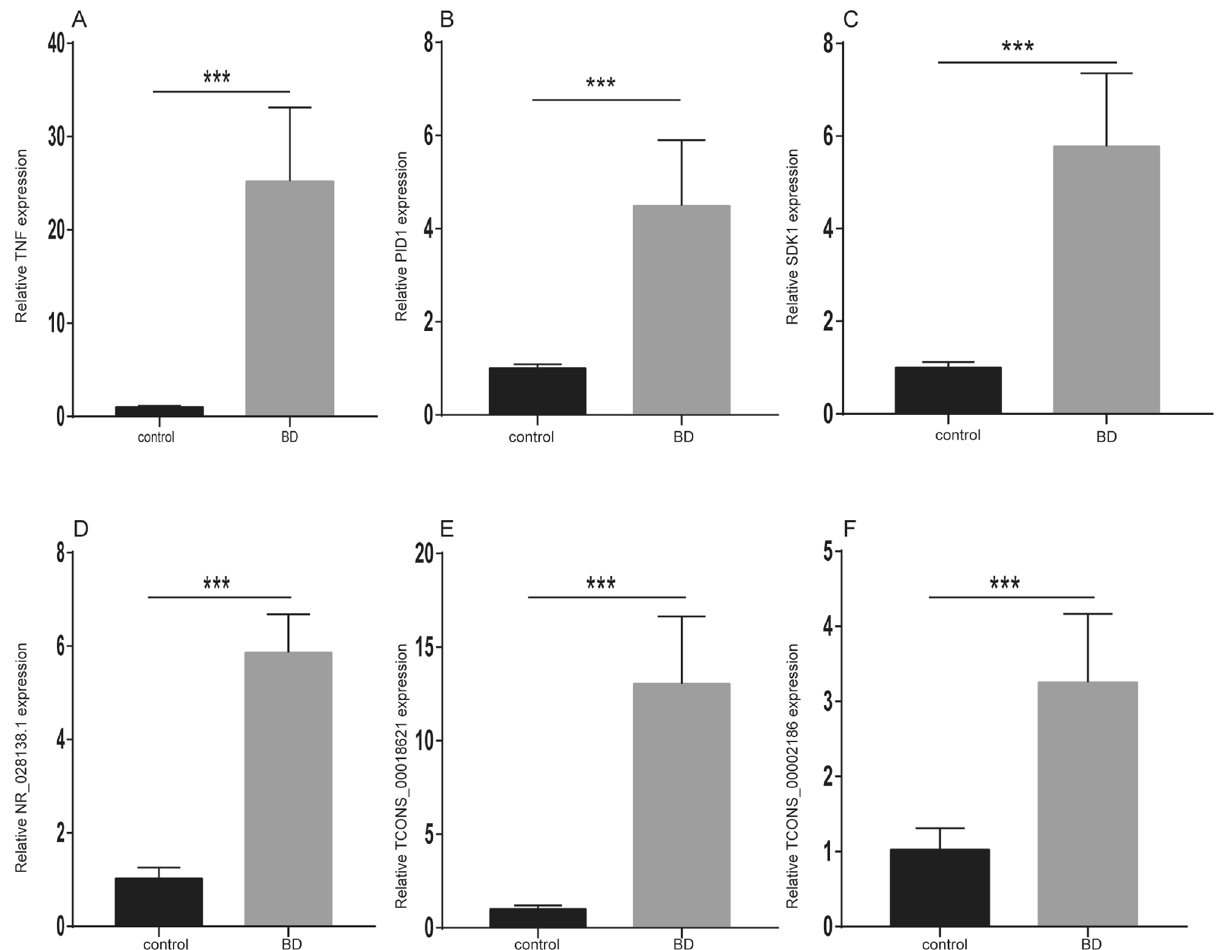
Figure 5. qRT-PCR validation of relative expression levels of six RNAs in BD patients and control subjects. ( A – F ) The expression of RNAs (TNF, PID1, SDK1, NR_028138.1, TCONS_00018621, and TCONS_00002186) in the BD and control groups. Black stars represent significant